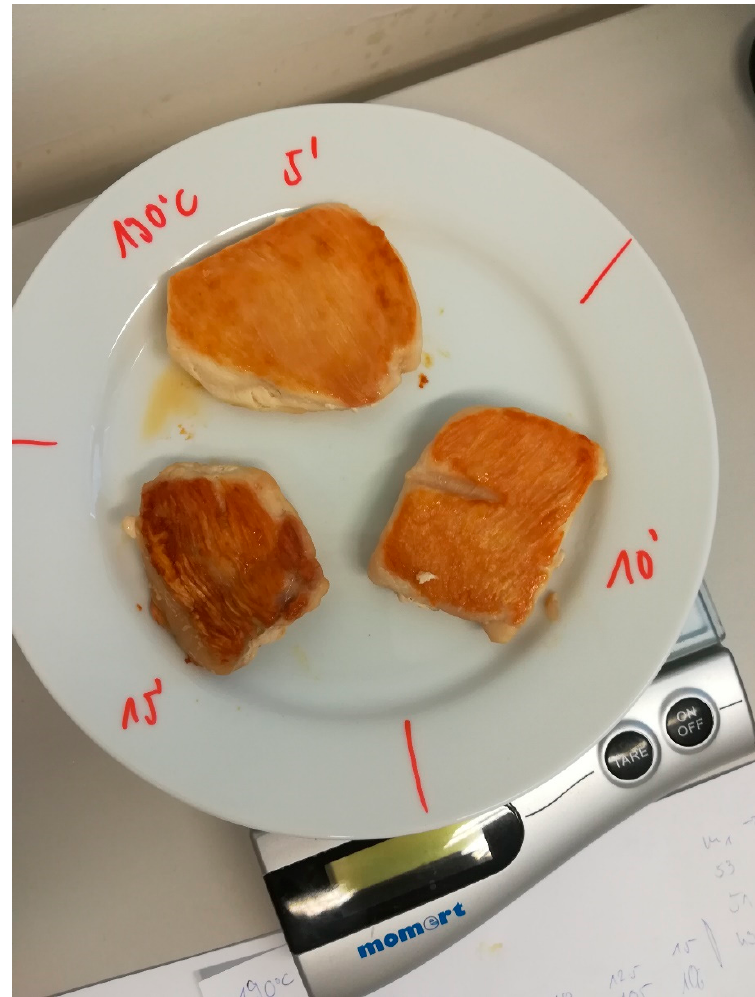
Picture 1. Comparison of colors of chicken breast samples without skin, grilled closed on 190 °C for 5, 10, and 15 min.